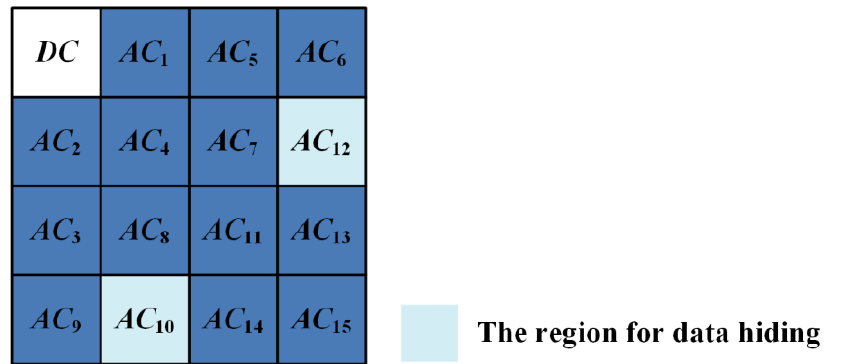
Figure 6. The region for data hiding.